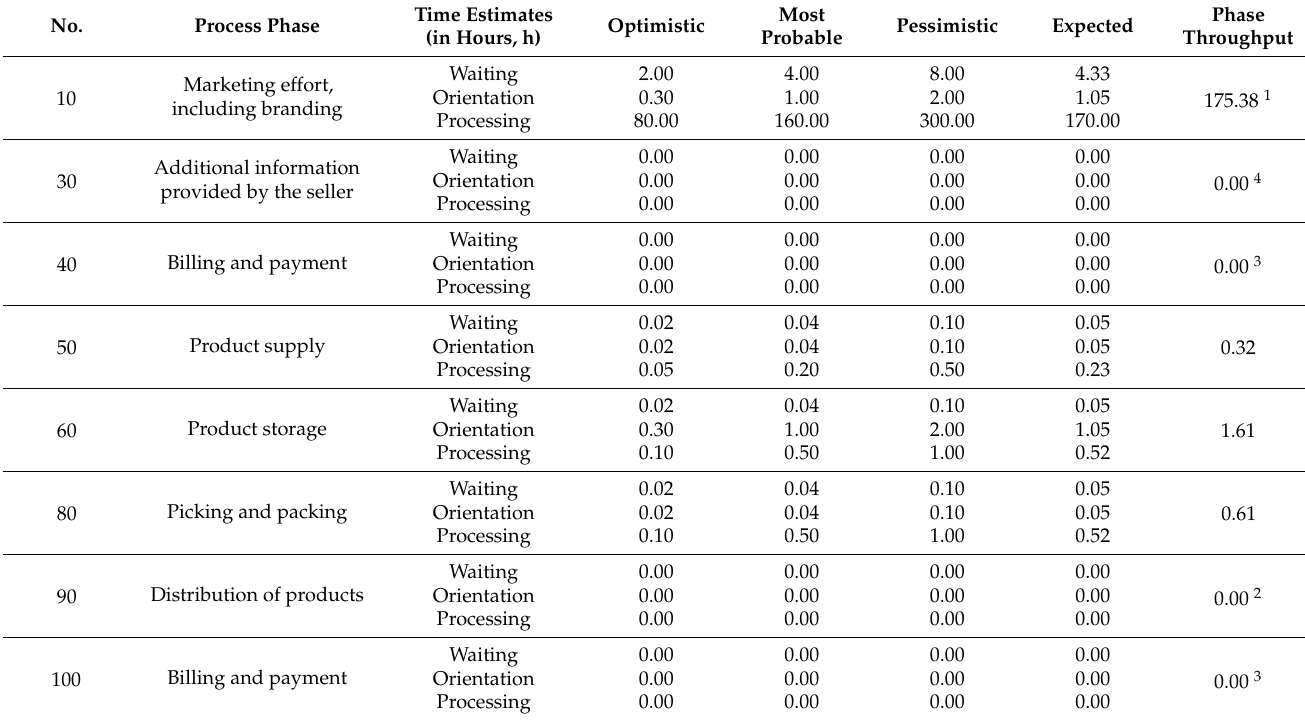
Table 9. Time estimates of the digital sales channel’